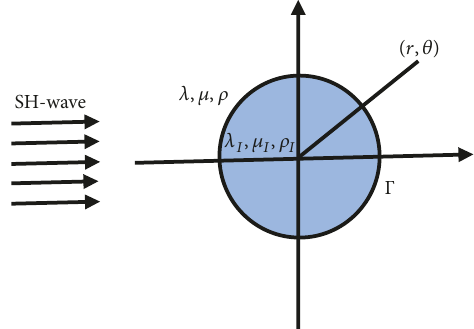
Figure 1: The scattering of SH-wave around a circular nanoinclu-